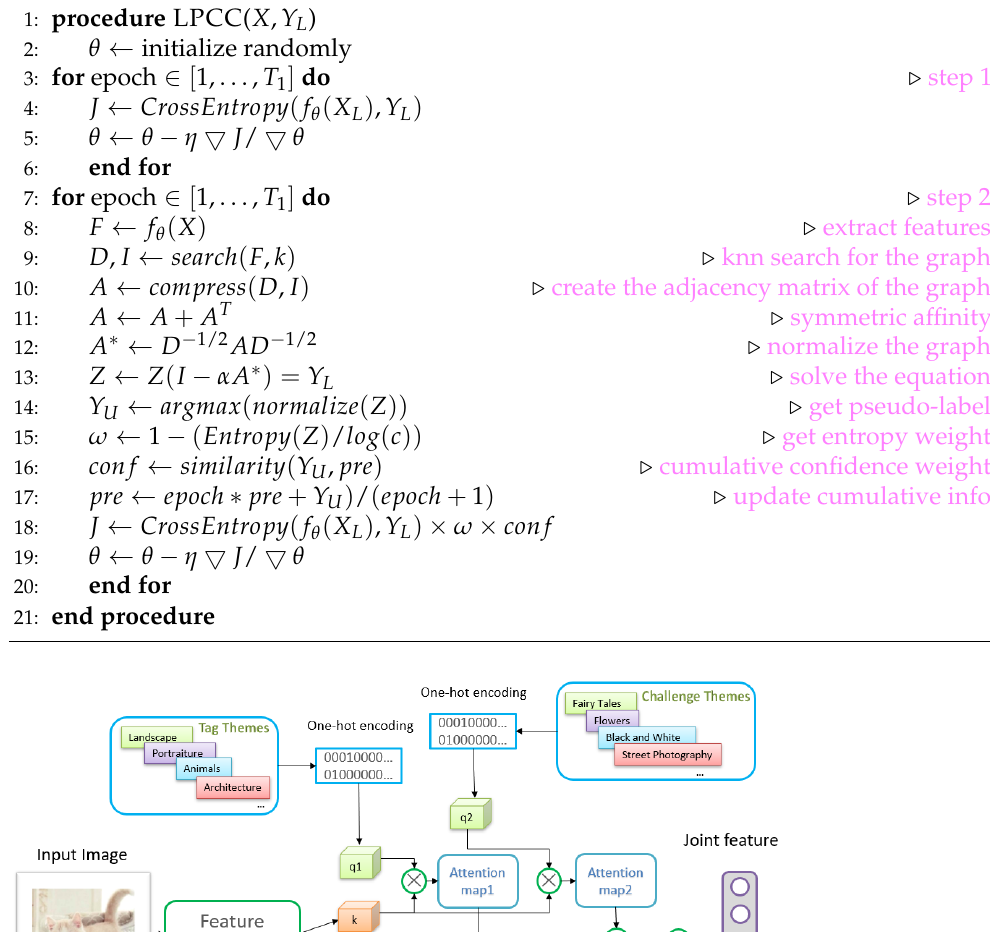
Algorithm 1 Label propagation with cumulative confidence.